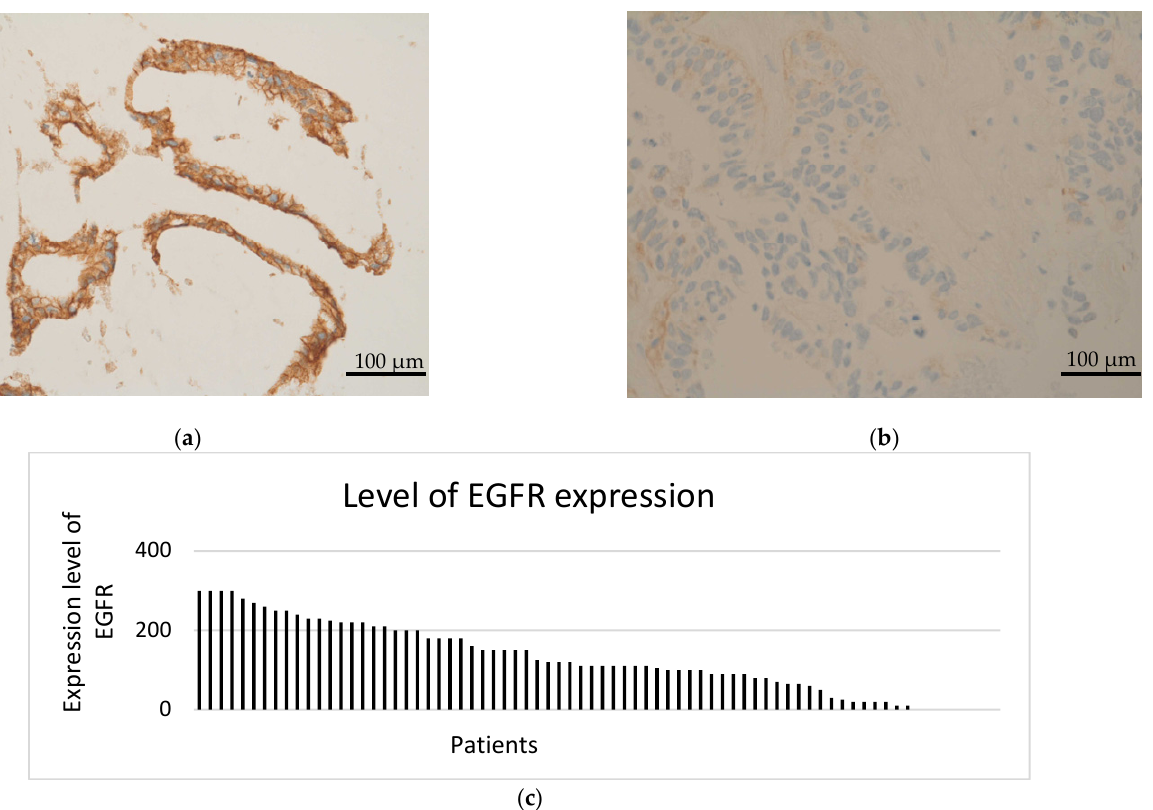
Figure 2. ( a ) Representative image of high expression of EGFR (IHC score = 300). ( b ) Representative image of low expression of EGFR. (Images by kind courtesy of Prof. Dr. Müllauer). ( c ) Level of EGFR expression in 71 patients with therapy − refractory solid tumors. Scale bar = 100 µm